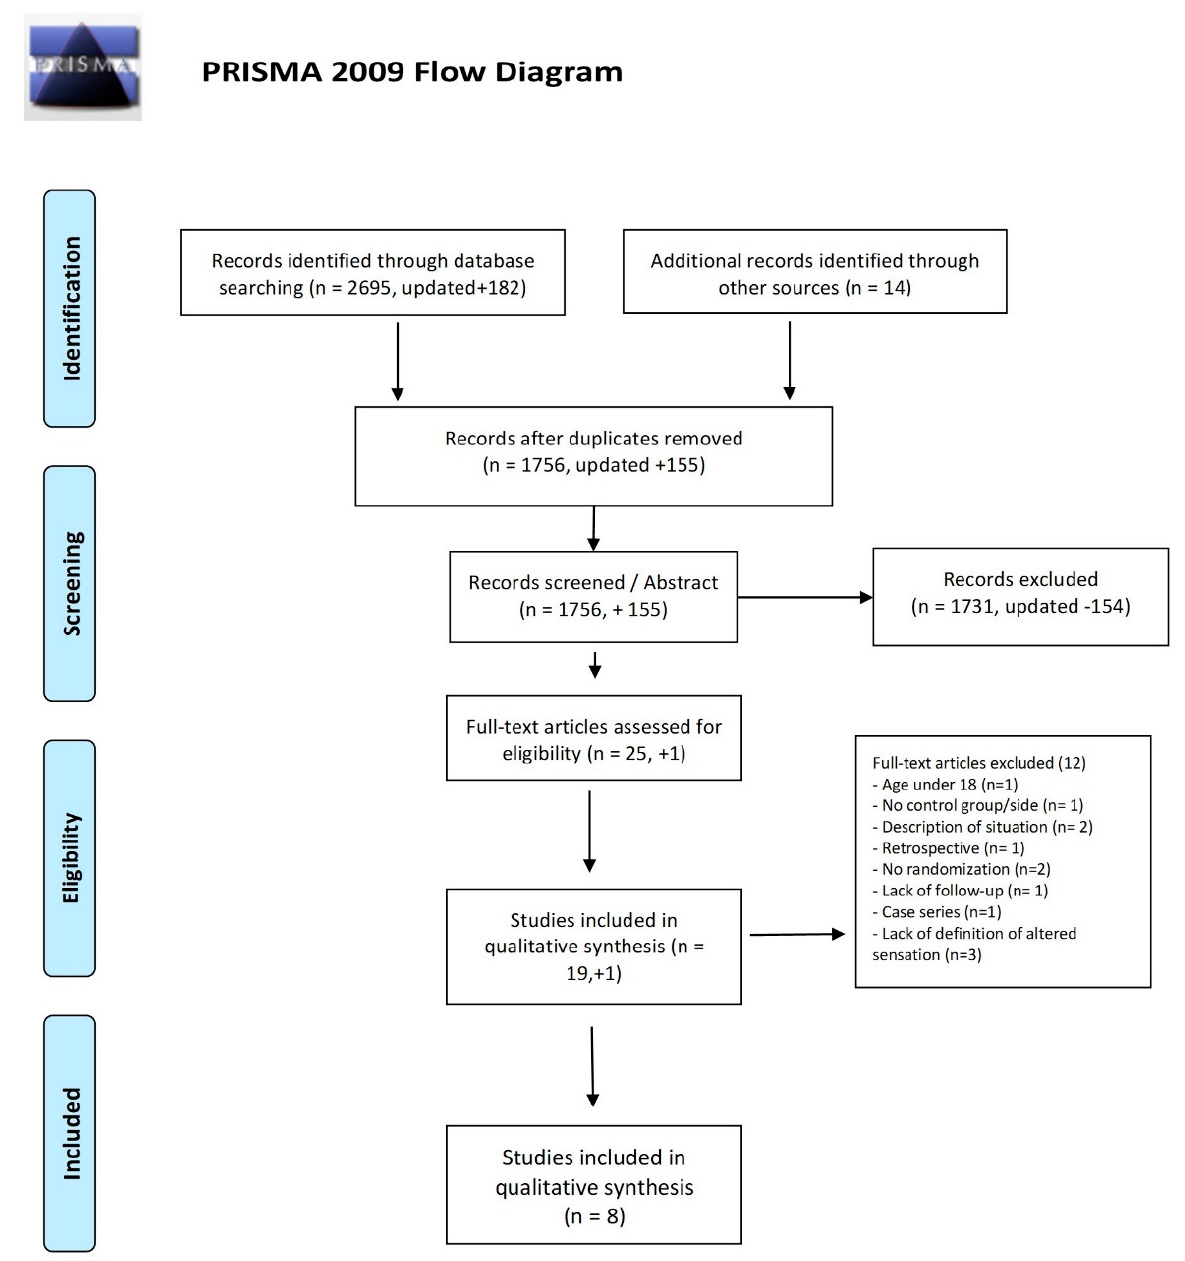
Figure 1. PRISMA flow diagram [ 40] .